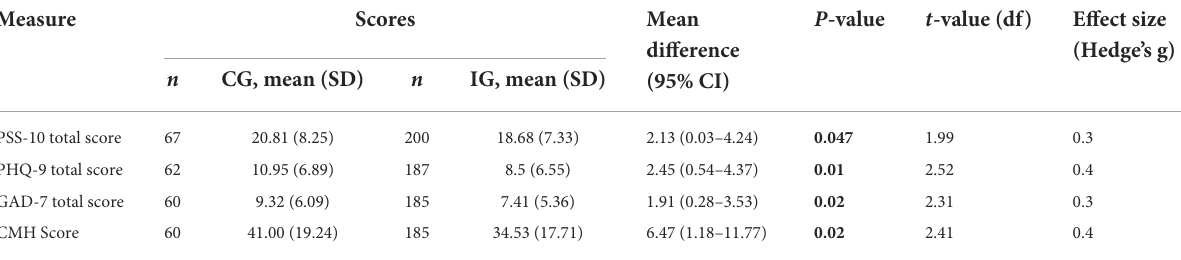
TABLE 2 Independent sample t-test comparing the mean scores for IG and CG on PSS, the GAD-7 and PHQ-9 scales and the Composite Mental Health (CMH) score. Measure